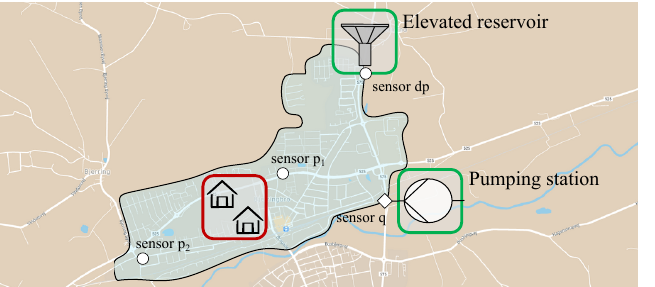
Figure 12. Map of Bjerringbro and its water distribution network scheme. Green and red blocks represent the main elements of the network which can be emulated with laboratory modules.